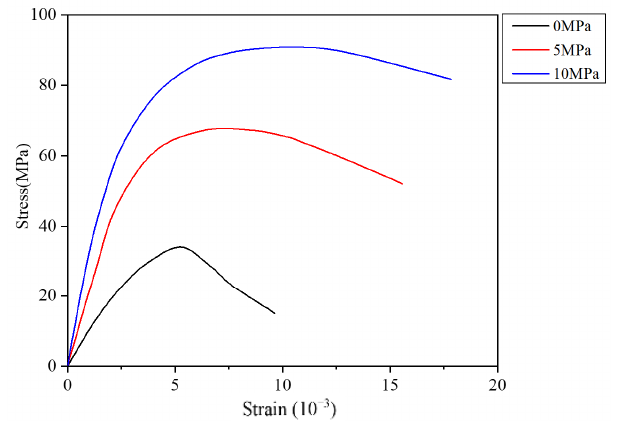
Figure 11. Stress–strain curve of SF10 specimens with 100 F–T cycles and 10 − 5 /s strain rate under Figure 11. Stress – strain curve of SF10 specimens with 100 F – T cycles and 10 −5 /s strain rate under different confining pressure. different confining